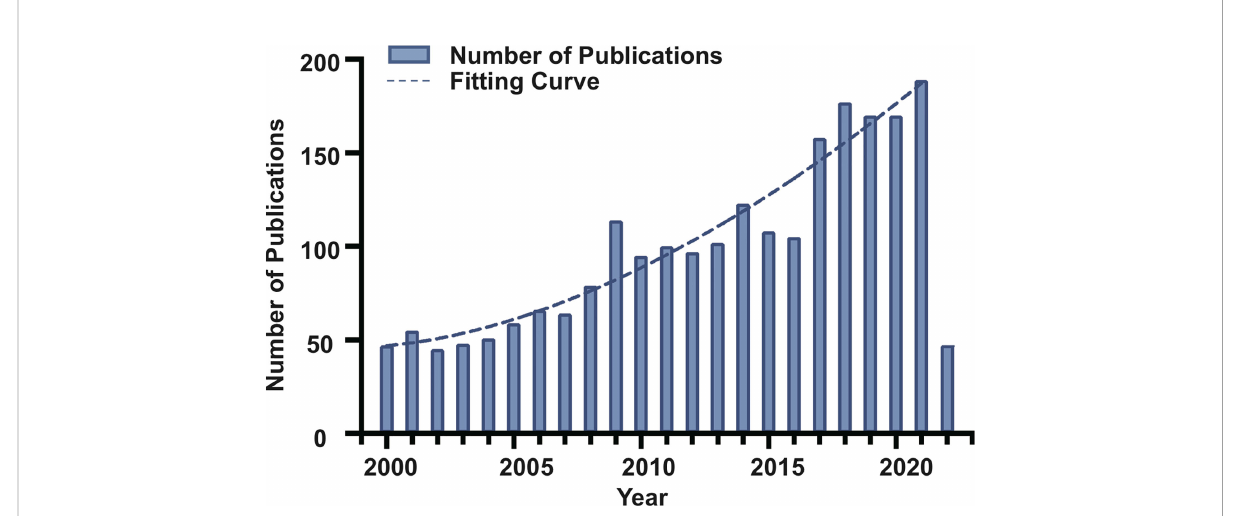
FIGURE 1 Trend of annual publication numbers and fi tting curve for chordoma research in the twenty- fi rst